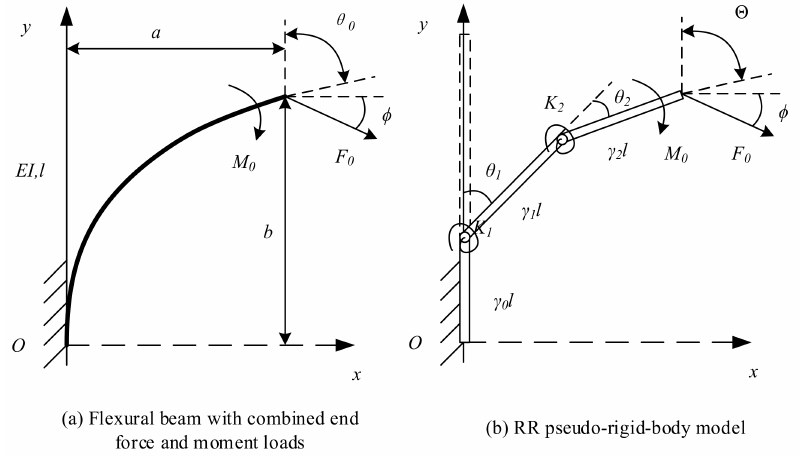
Figure 2. A large deformation flexural beam ( a ) and the RR PRBM ( b